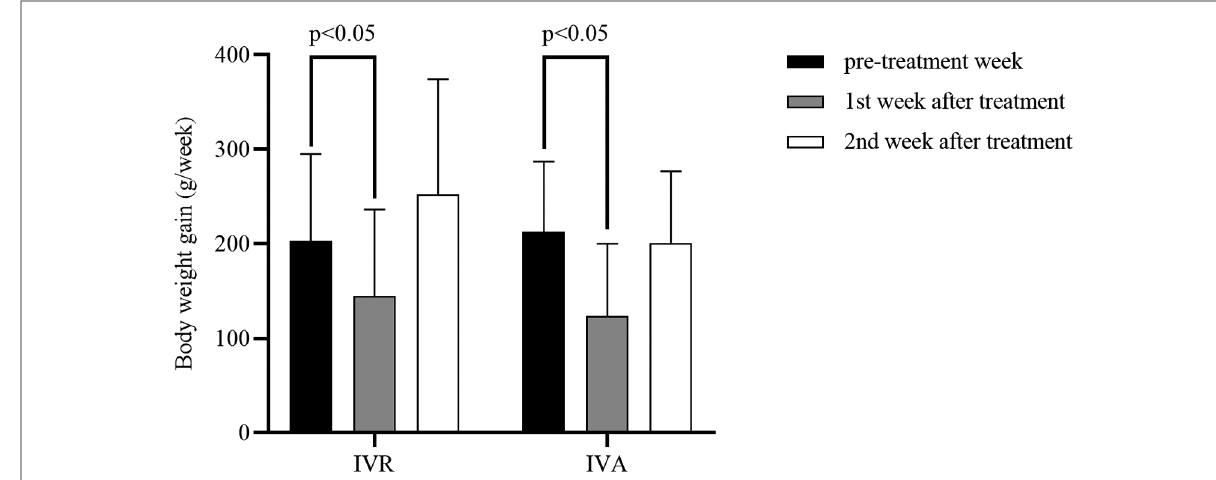
FIGURE 1 Comparison of weekly BW gain before and after treatment in the two groups.